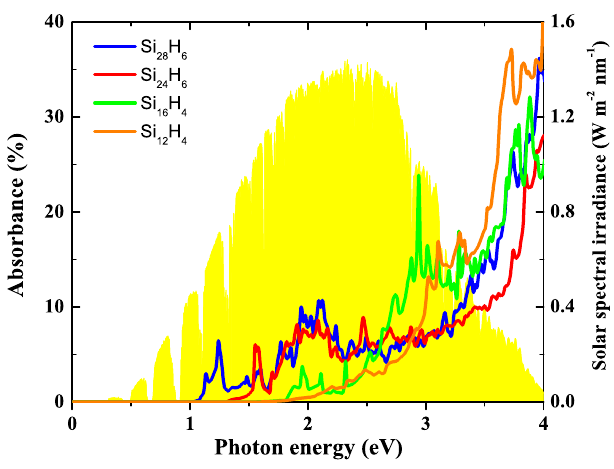
FIG. 8. The calculated optical absorbance spectra of Si 28 H 6 , Si 24 H 6 , Si 16 H 4 , and Si 12 H 4 . The reference air-mass 1.5-solar- spectral irradiance is plotted in